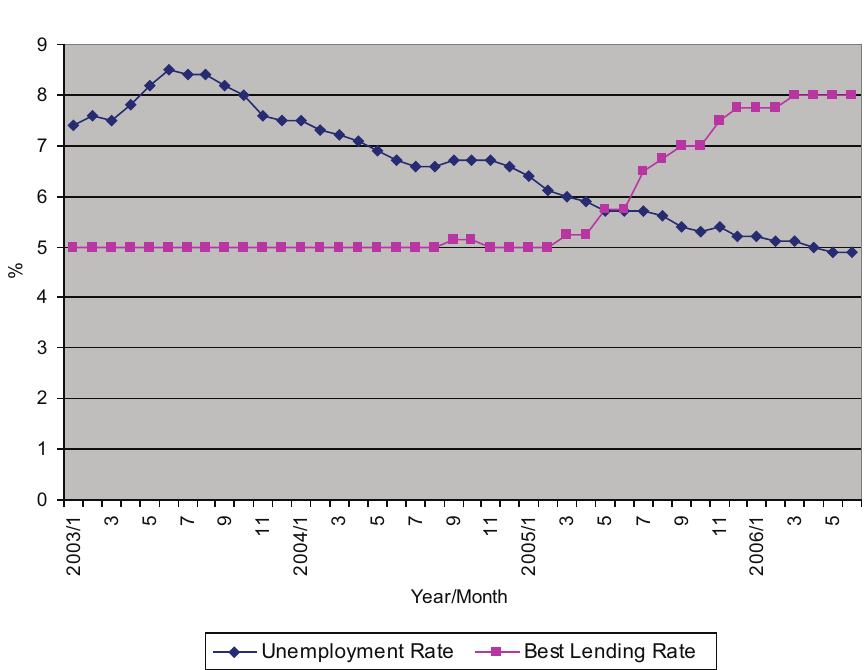
figure 2. Hong Kong’s unemployment rate and best lending rate (Sources: Census & Statistics Department and